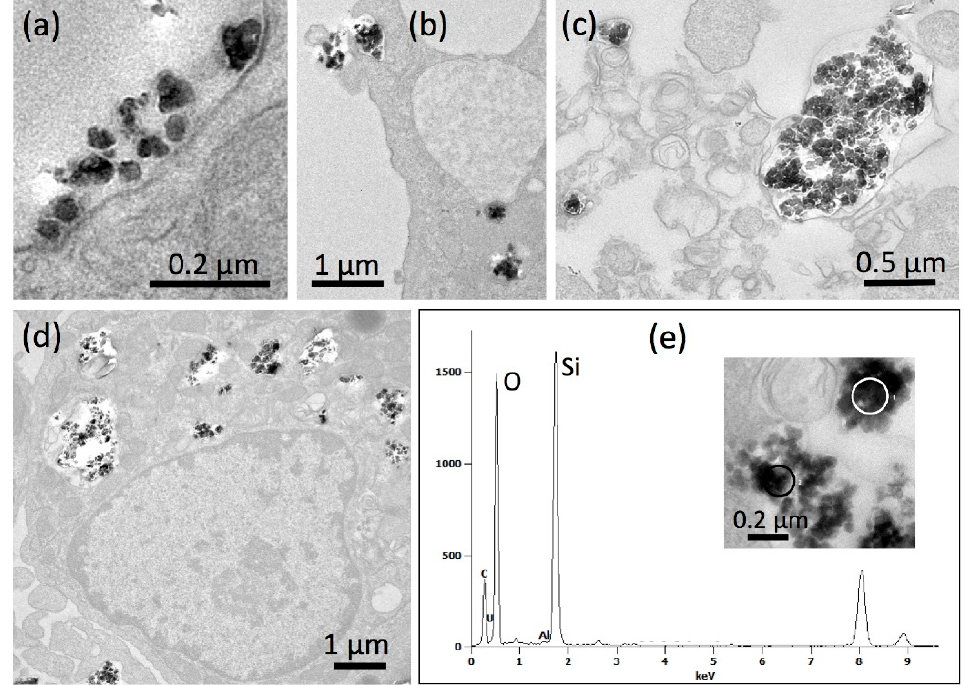
Figure 5. Detection of precipitated P-6 silica nanoparticles in NR8383 cells by transmission electron microscopy (TEM). Cells were treated with 67.5 µ g P-6 per mL in serum-free F-12K and fixed after 90 min ( a , b ) and 16 h ( c – e ). ( a ) P-6 NP attached to the cell; the underlying cell membrane appears undamaged. ( b ) Early stage of phagosome formation (upper left). ( c ) A P-6-filled phagolysosome released from a deteriorated cell. ( d ) NR8383 macrophage filled with numerous P-6-laden phagosomes. ( e ) Energy dispersive X-ray analysis (TEM-EDX) of a P-6-containing phagosome; white circle (inset) marks the analyzed area; results from black circle were highly similar (not shown). Prominent signals (in arbitrary units) were obtained for silicon (Si) and oxygen (O) at typical positions (in keV) of the spectrum.